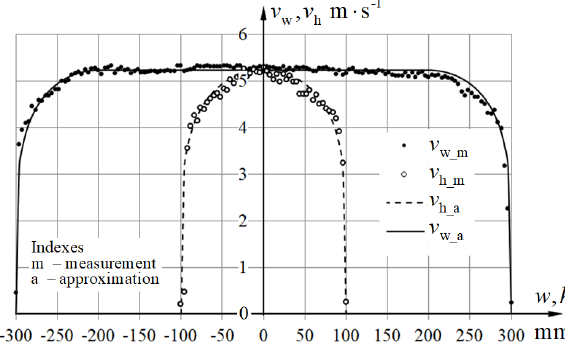
Fig. 8 An approximation of the measured velocity distribution using the new